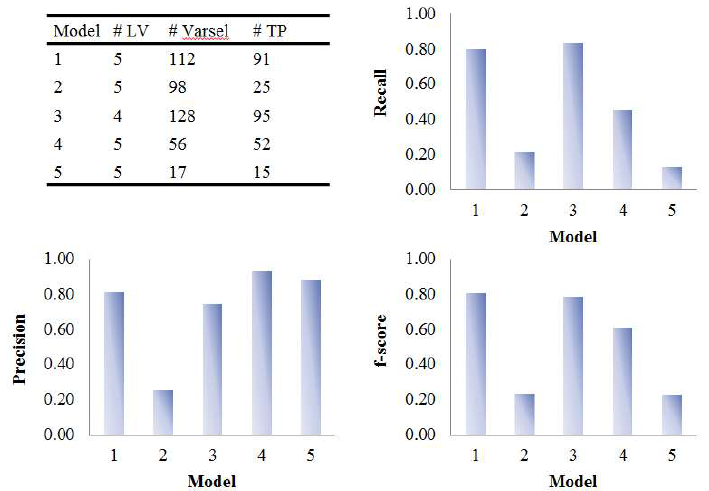
Figure 10. Evaluation of the variable selection performance of five PLS models on coffee study data. Recall, precision and F 1 -score were calculated based on the variable selection confusion matrix. # LV, number of latent variables; # Varsel, number of selected variables; # TP, number of true positives.